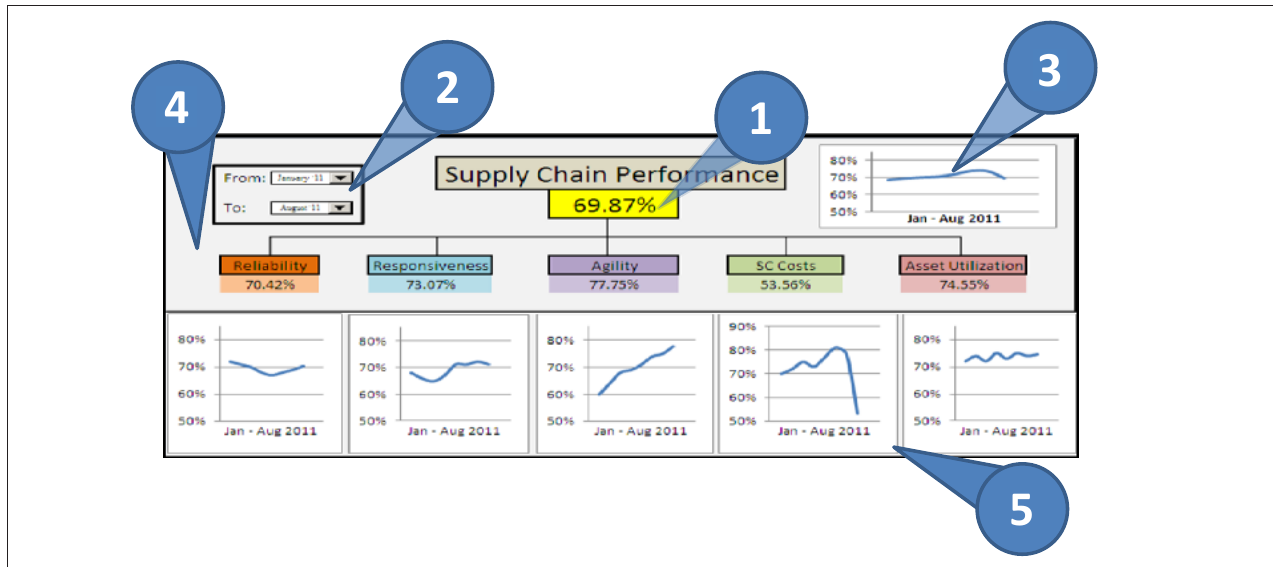
FIGURE 4: A final dashboard format for management.